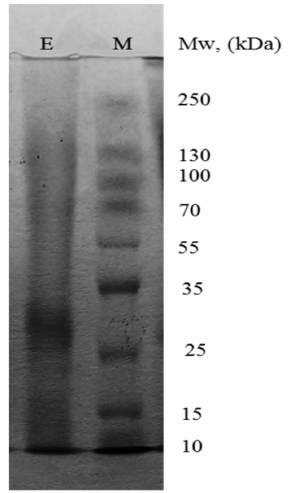
Figure 1. SDS-PAGE of the purified lipase from Brevibacillus thermoruber strain 7. E, purified enzyme; M, molecular mass markers.